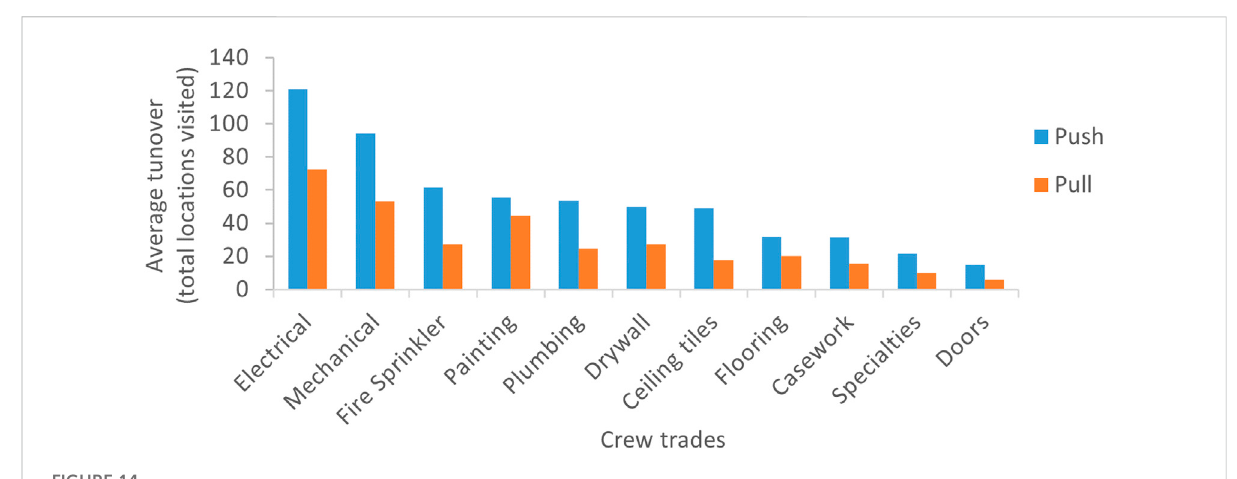
FIGURE 14 Average turnover for all crew